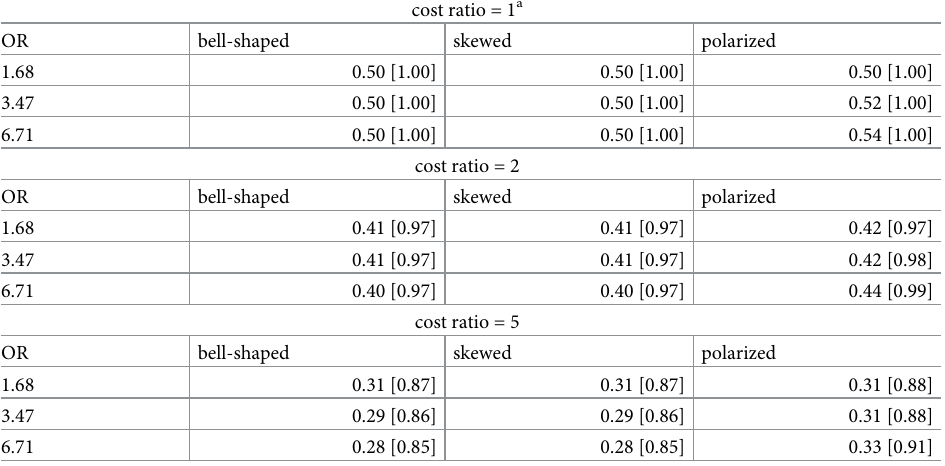
Table 3. Optimal proportion of subjects in the intervention [efficiency of the balanced design] for seven response